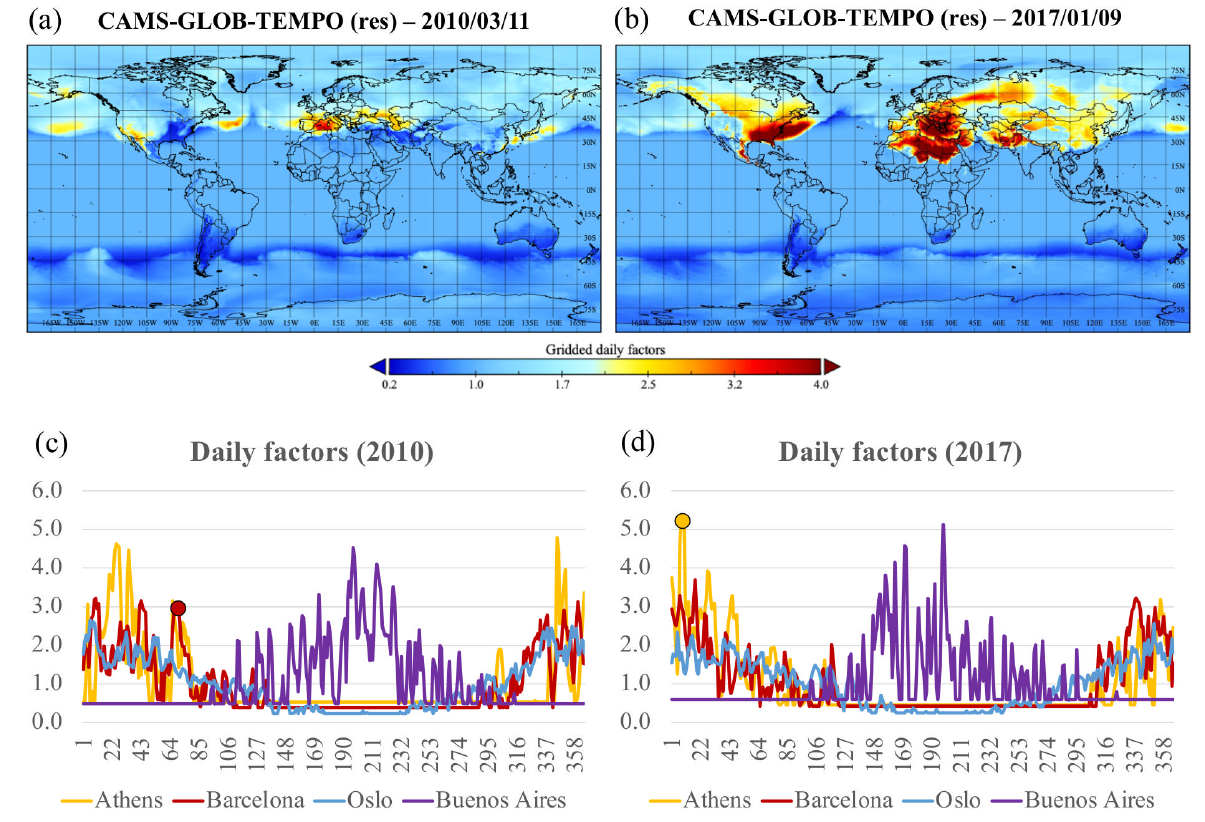
Figure 6. CAMS-GLOB-TEMPO (0.1 × 0.1 ◦ ) daily-scale factor maps for residential and commercial (res) emissions for 11 March 2010 (a) and 9 January 2017 (b) . Daily factors obtained over the cities of Athens, Barcelona, Buenos Aires and Oslo for 2010 (c) and 2017 (d) . The red and yellow circles on the plots indicate the cold outbreaks experienced in Barcelona (11 March 2010) and Athens (9 January 2017), respectively. Administrative boundaries are derived from the Micro World Data Bank (MWDB2,